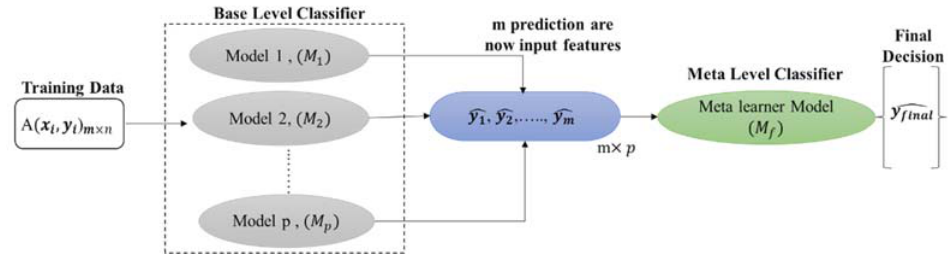
Figure 3. Stacking model architecture.